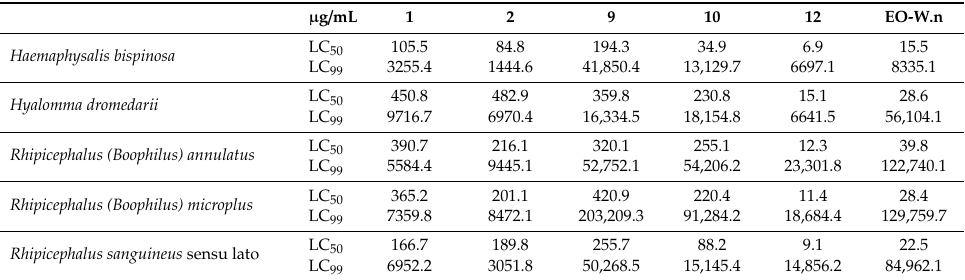
Table 7. Acaricidal activity against tick species for compounds. Sandaracopimaric acid (1), Z -communic acid (2), pisiferal (9), pisiferic acid (10), guaiol (12), and essential oil from W. nodiflora timber (EO-W.n). LC 99 values were extrapolated using probit